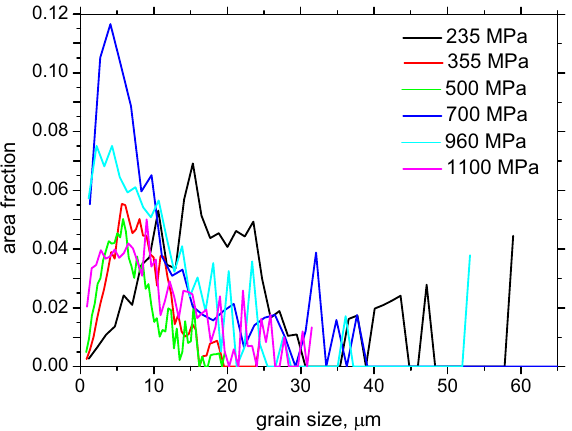
Figure 5. Distribution of grain size as a function of nominal σ YS